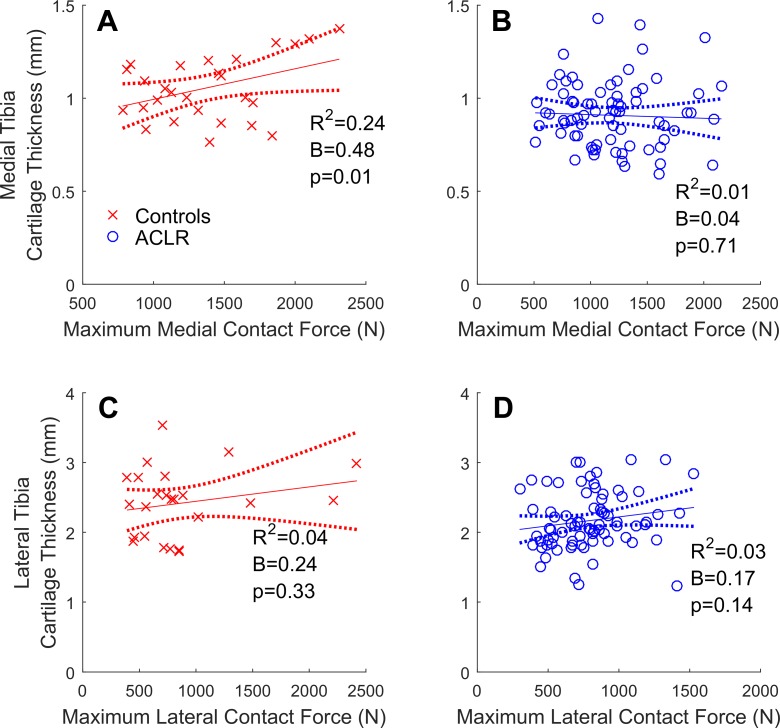
Tibial articular cartilage thicknesses (mm) regressed onto maximum walking tibiofemoral contact forces (N) with the 95% confidence intervals (dotted lines) for the control (cross-hairs) and overall cohort of ACLR knees (circles). (A and B) Medial compartment; (C and D) lateral compartment. ACLR, anterior cruciate ligament reconstruction.